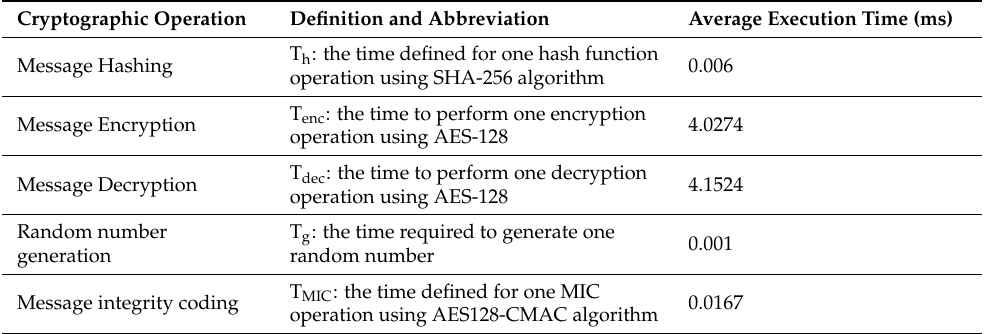
Table 4. The definition and processing time of the primary cryptographic operations of NS3 Simulator for the proposed